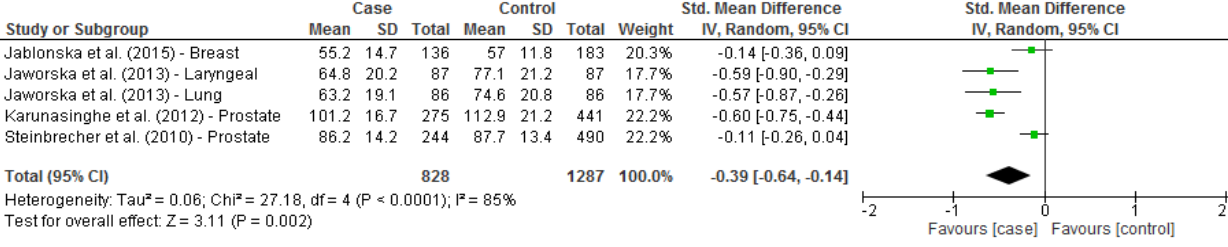
Figure 5. Forest plot of standardized mean difference (SMD) of selenium levels between cases and controls [17,19,20,37].